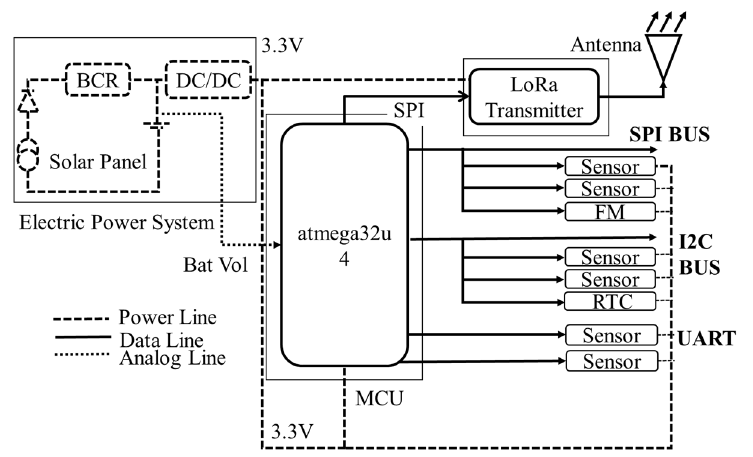
Figure 7. Block diagram of GST for implementation.